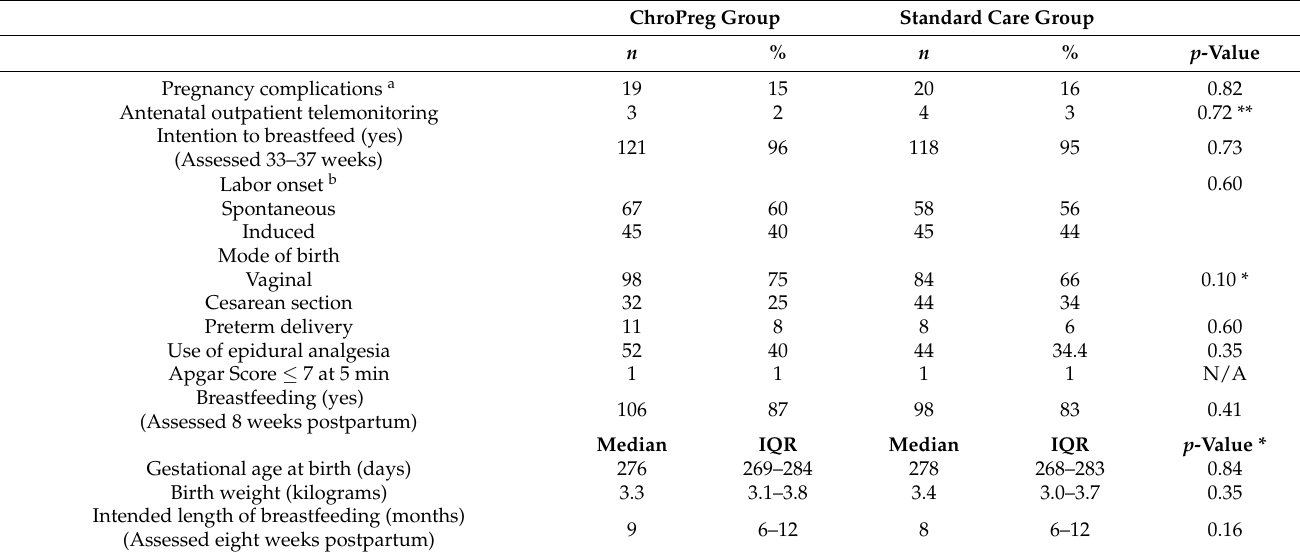
Table 5. Maternal and infant outcomes for the intention-to-treat population according to allocation.